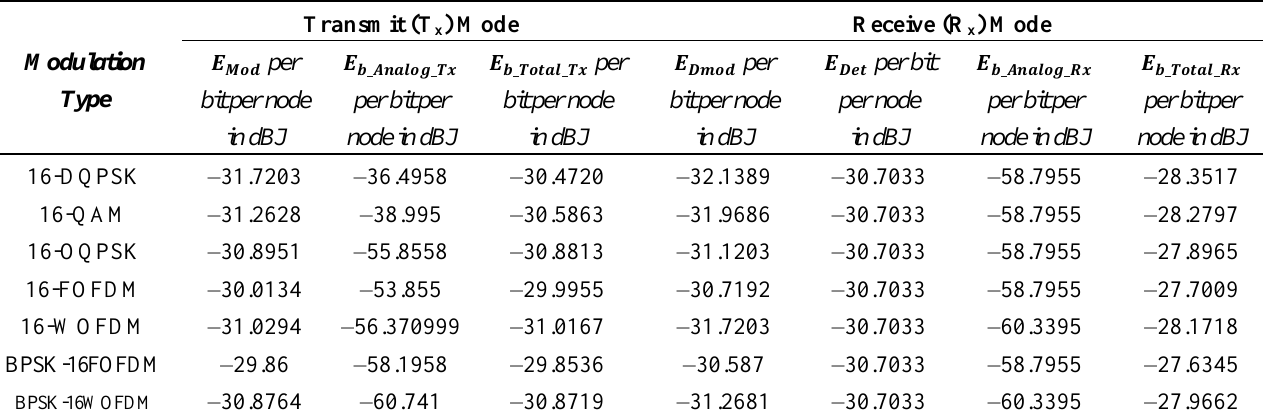
Table 3. Energy Consumption in Transmit and Receive